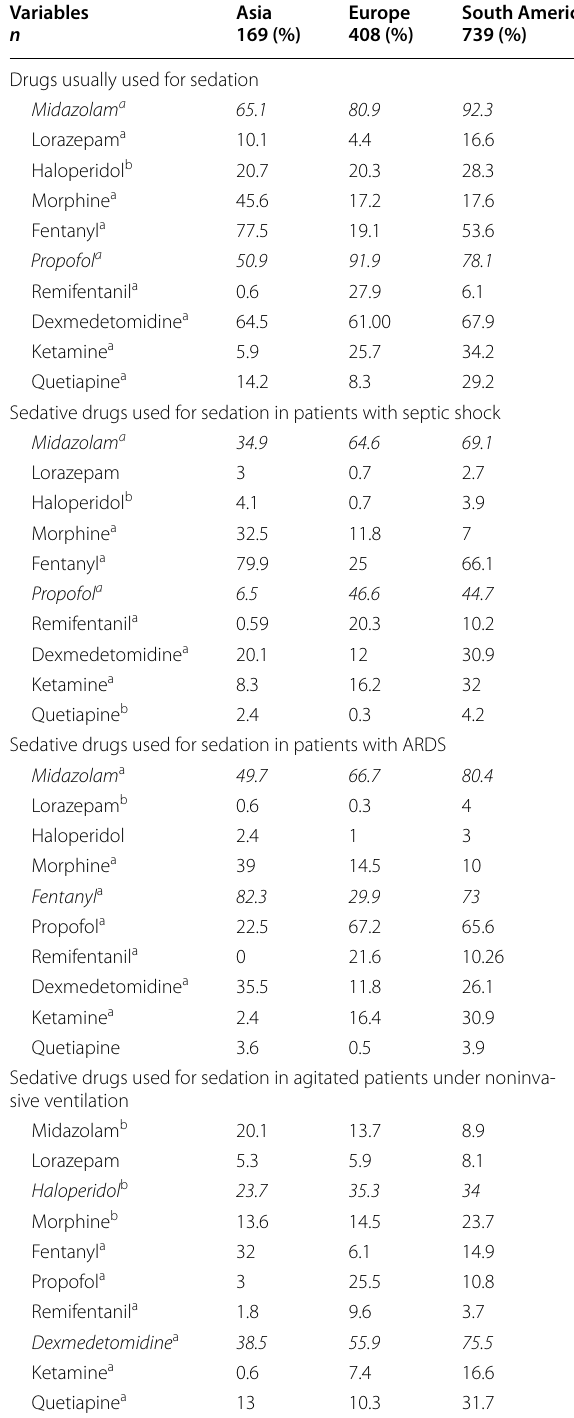
Table 2 Sedation choices by continent before the COVID‑19